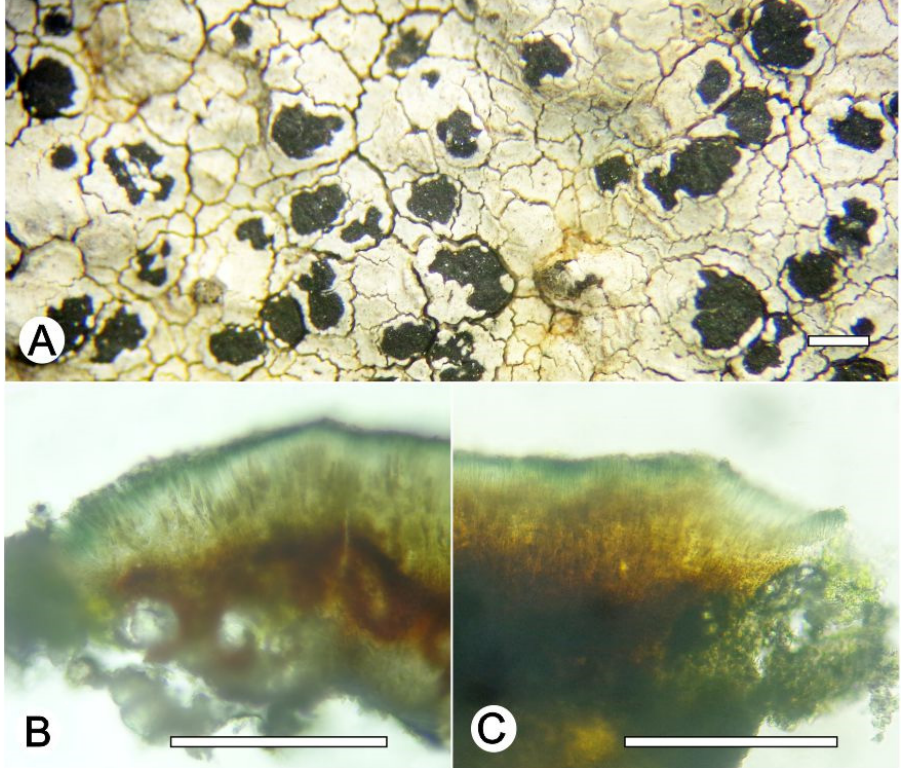
Figure 8. Lecanora nigrilobulata sp. nov. ( A ) Thallus with ascomata (holotype ISE-52239); ( B ) Apothe- cial section in water (holotype ISE-52239); ( C ) Apothecial section after KOH treatment (holotype ISE-52239). Scale bars: ( A ), 1 mm; ( B , C ), 100 µ